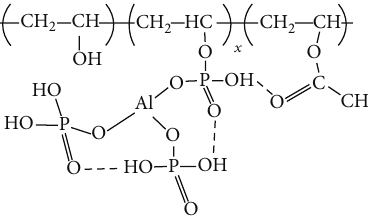
Figure 9: Model structure of PPVA-ALPO 4 network.